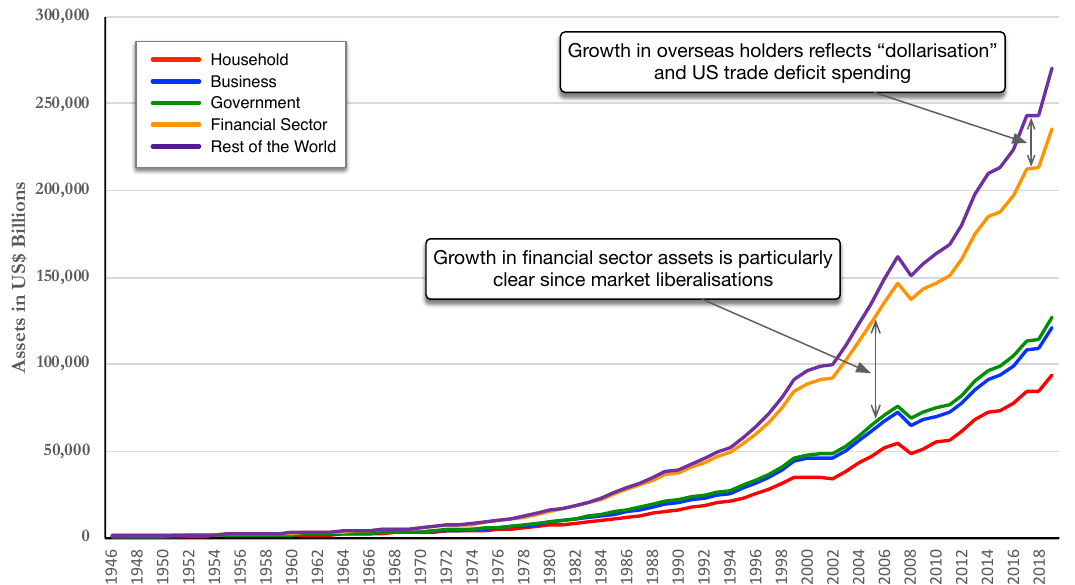
Figure 1. Growth in US Dollar financial assets, cumulative view (US Federal Reserve System 2020b).